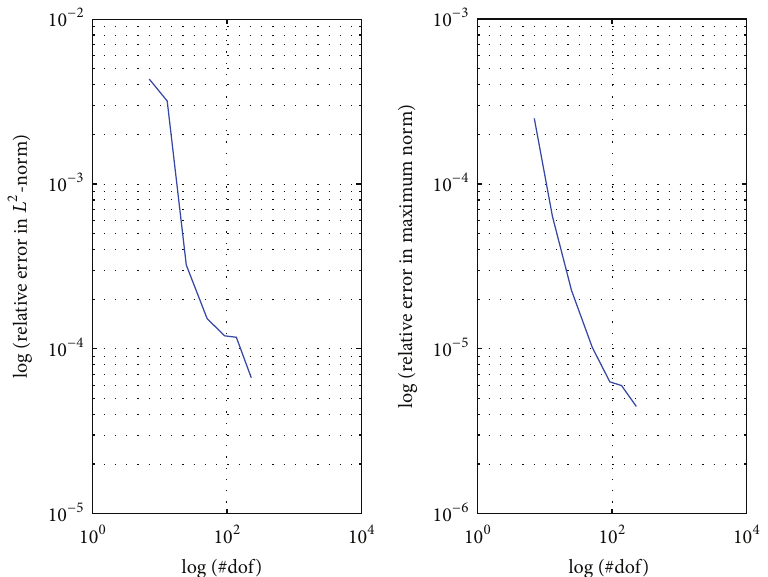
Figure 5: Convergence graphs of relative error in 𝐿 2 -norm and maximum norm via Sloan iteration for (46) in Example